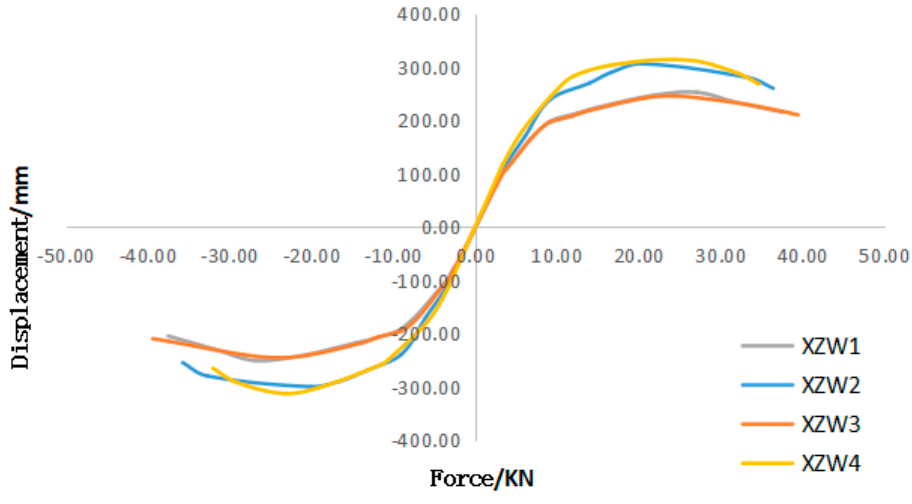
Figure 7. Skeleton curves of specimens.